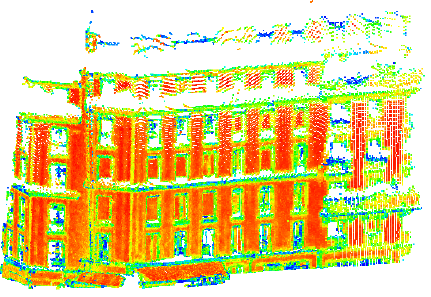
Figure 5: Entropy E f , ranging from 0 (blue) to 1 (red). Local registration The four steps of the ICP algorithm are: (1) selecting a reduced number of points, (2) finding matching points, (3) weighting each corresponding pair, and, finally, (4) designing and minimizing a given error metric. Using geometric